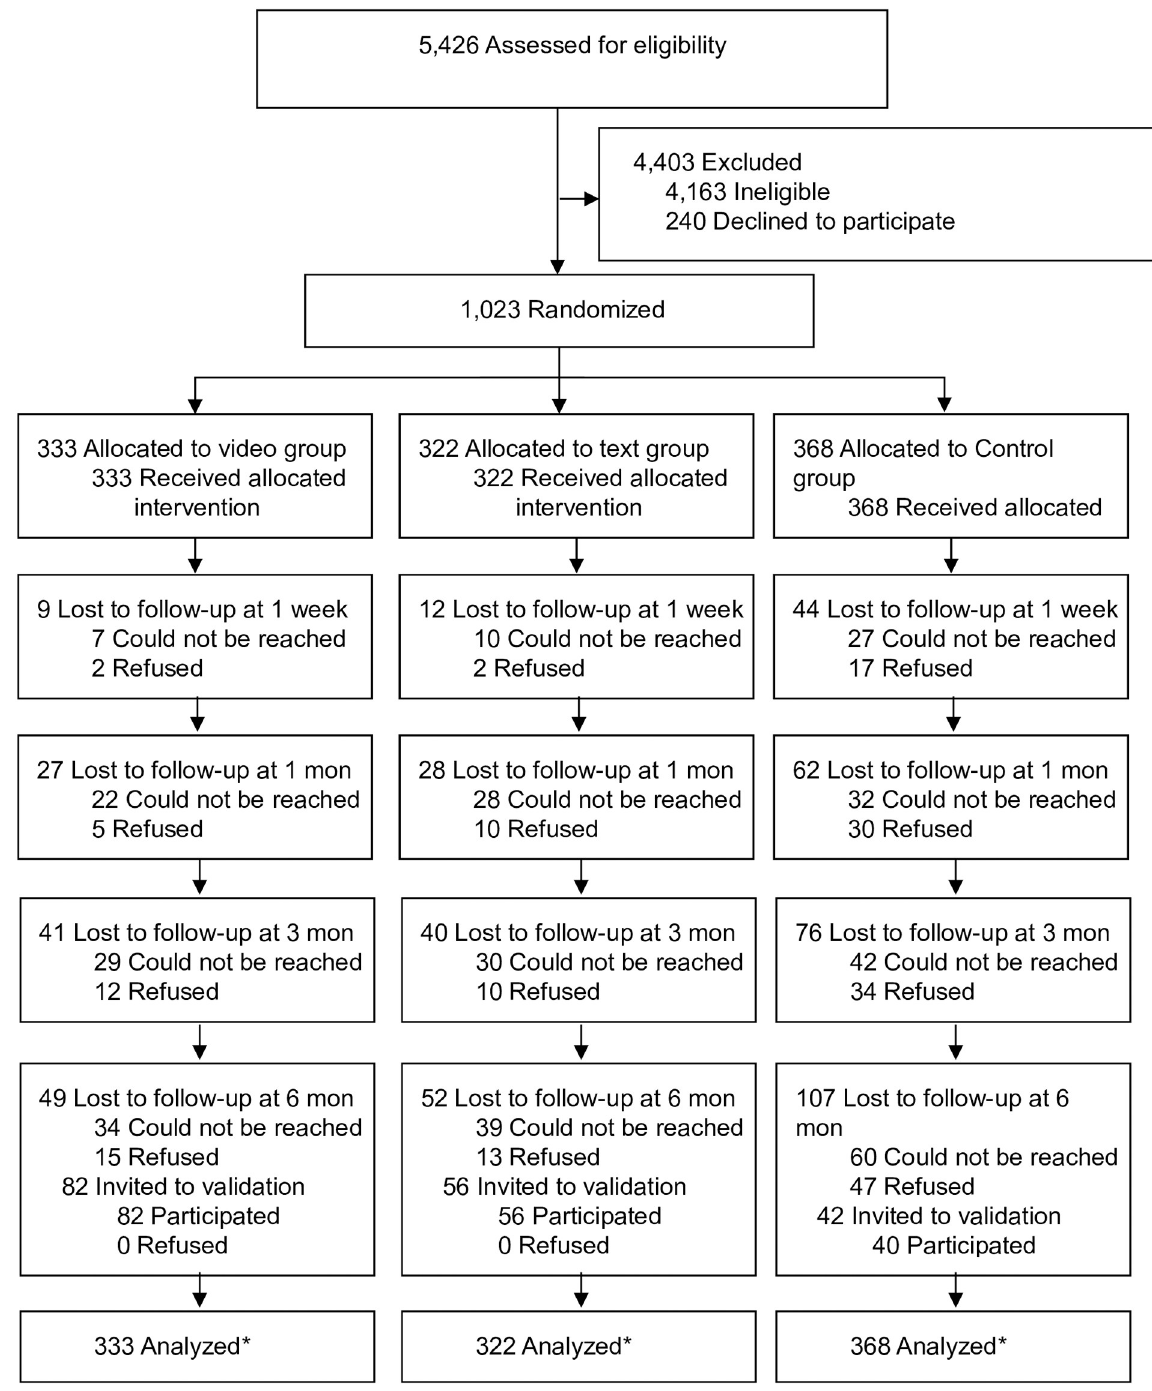
Fig 1. CONSORT flow diagram of participants through trial. Participants who were lost to follow-up previously were contacted again in the next follow-up. � An ITT analysis was performed by included all cases with the assumption that all participants lost to follow-up were smokers with unchanged smoking habits. CONSORT, Consolidated Standards of Reporting Trials; ITT, intention to